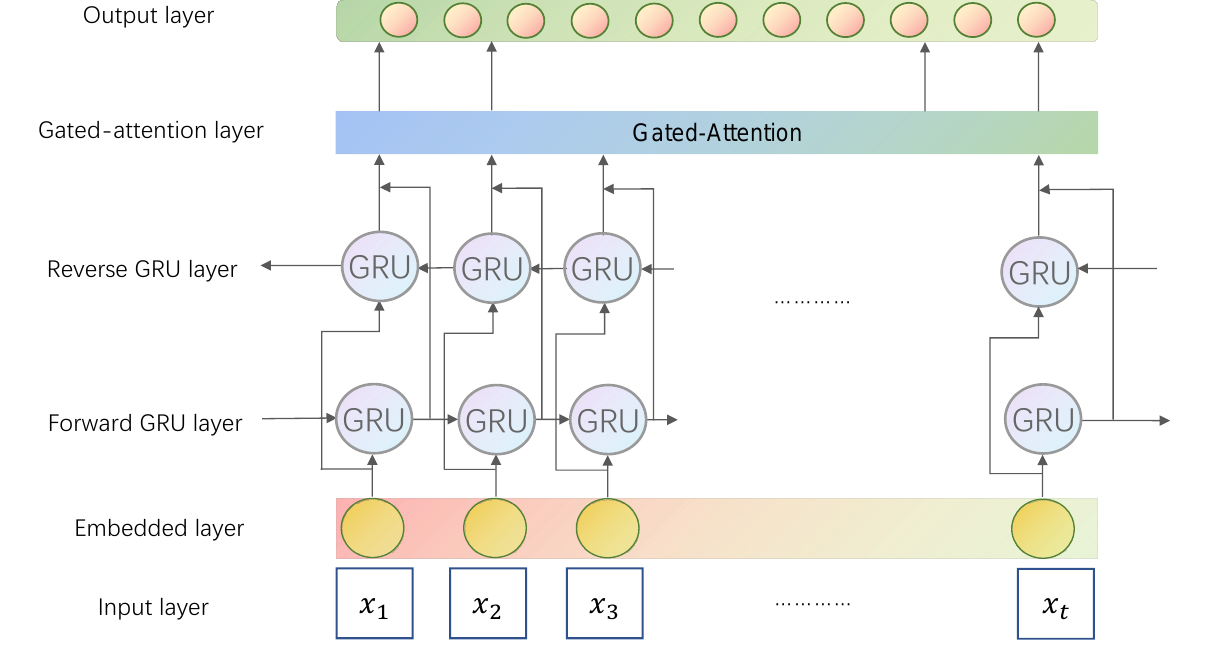
Figure 7. BiGRU-GA relation extraction model.